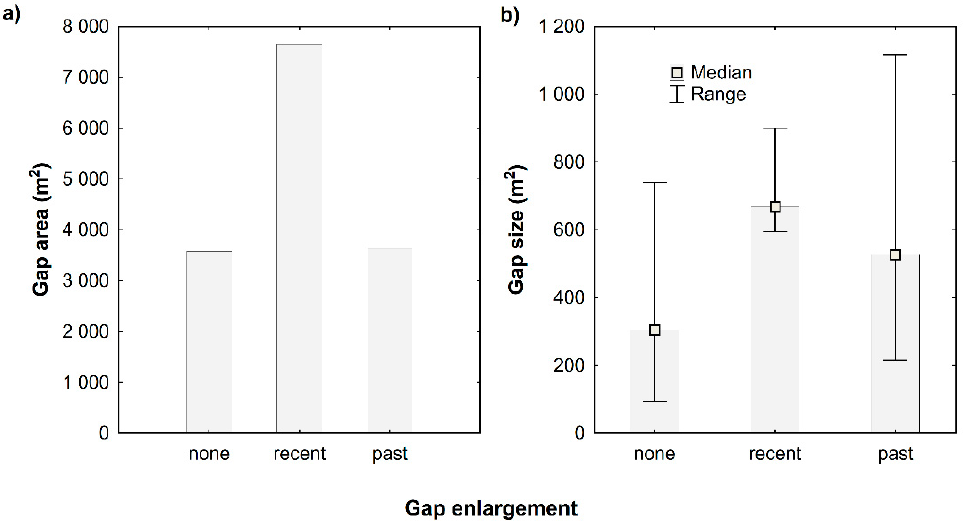
Figure 4. ( a ) Total gap area and ( b ) median size of expanded gaps according to enlargement categories. Range of individual gap sizes is shown without outliers.